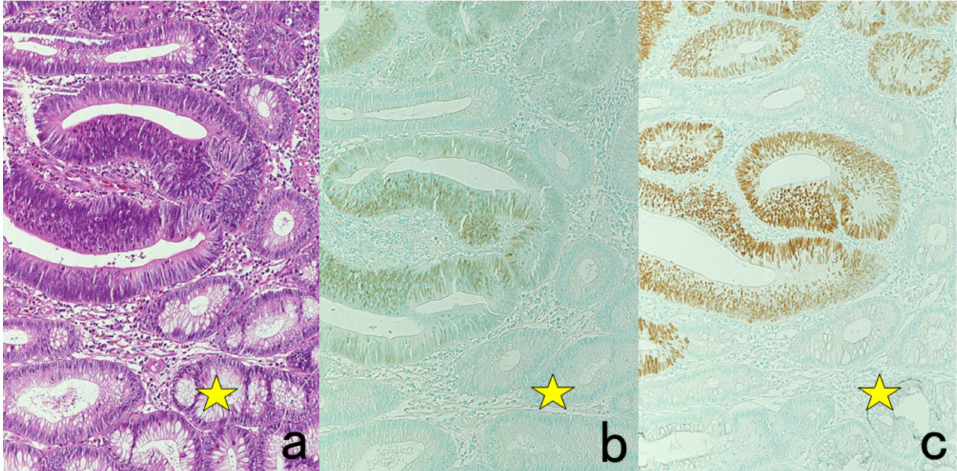
Figure 34. Application of HIER (I). p53 expression in cancer in adenoma of the colon. ( a ): H&E, ( b ): immunostaining without HIER and ( c ): immunostaining after HIER with autoclaving at 121 ◦ C for 10 min in 10 mM citrate buffer, pH 6.0. The nuclei of adenocarcinoma cells express p53, whereas the surrounding adenoma cells (stars) remain negative. The nuclei are counterstained with methyl green.